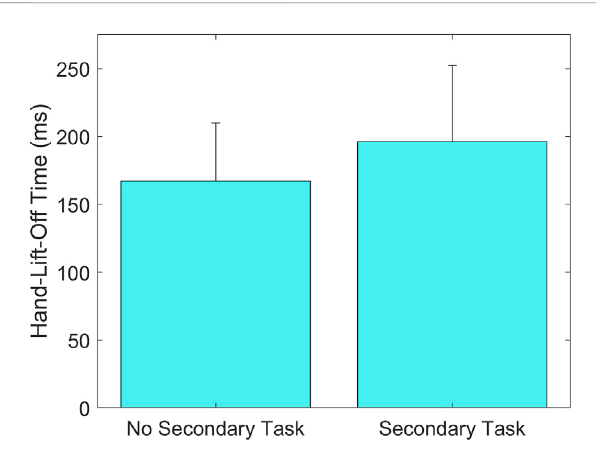
FIGURE 10 Group means ± SD for Hand-Lift-Off Time without and with the Secondary Task.